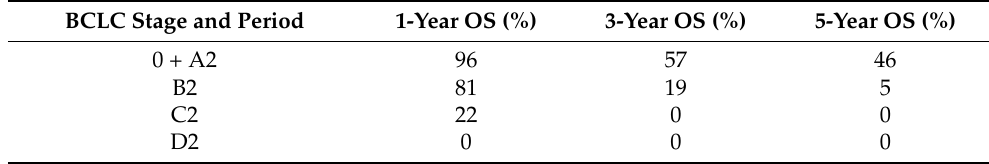
Table 4. Overall survival rates in 1, 3, and 5 years in the 2nd period. BCLC Stage and Period